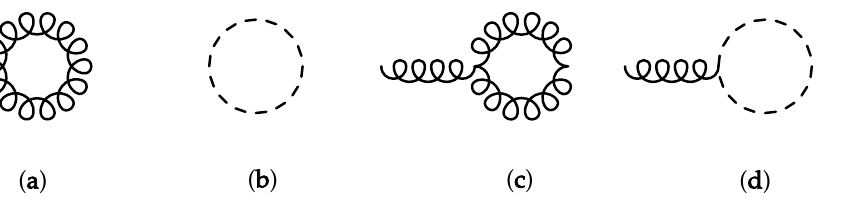
Figure 8. Vacuum and tadpol Figure 7. vacuum and tadpol diagrams